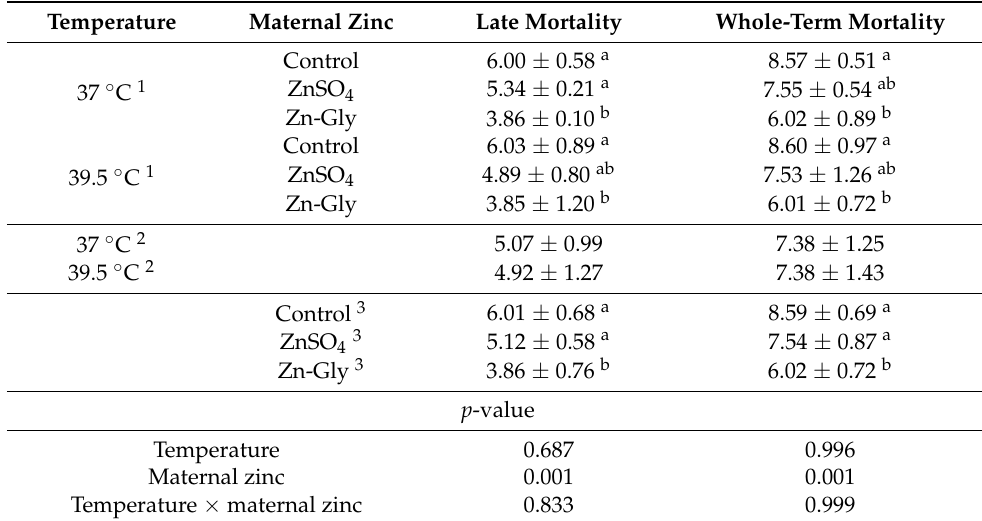
Table 3. Effects of maternal zinc on embryo mortality under heat stress (%) (mean ± S.E.).